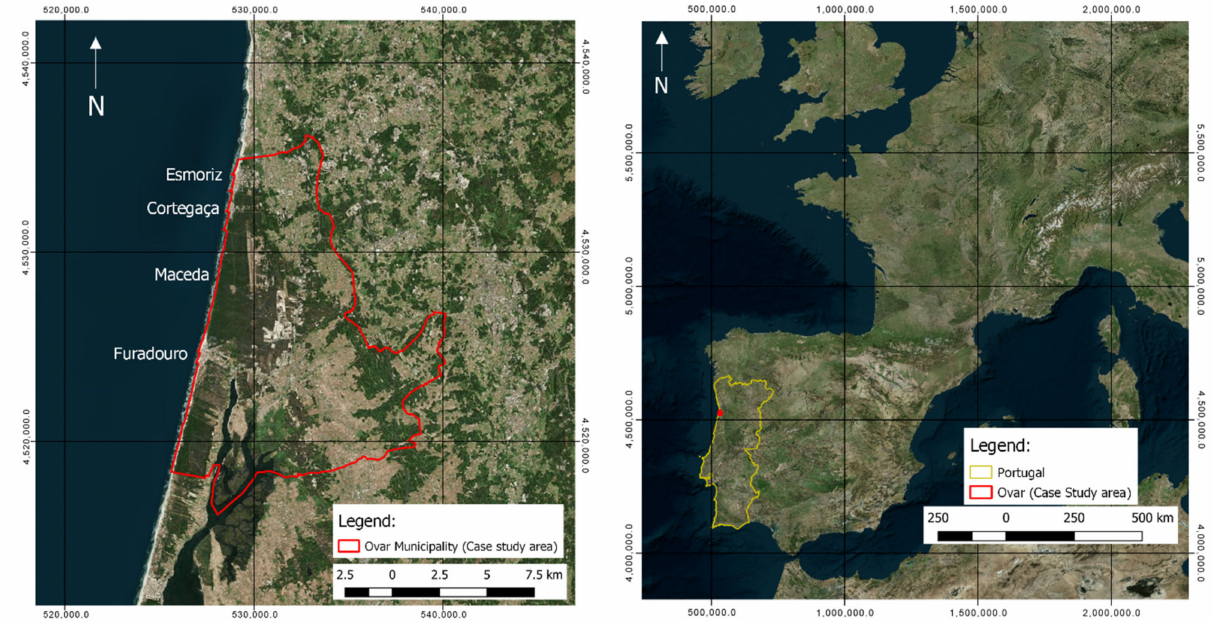
Figure 1. Maps of the study region, the Municipality of Ovar (Portugal, to the left ) as well as a more global view of the region and the country in the European continent (to the right ). All coordinates presented are in WGS 84/UTM zone